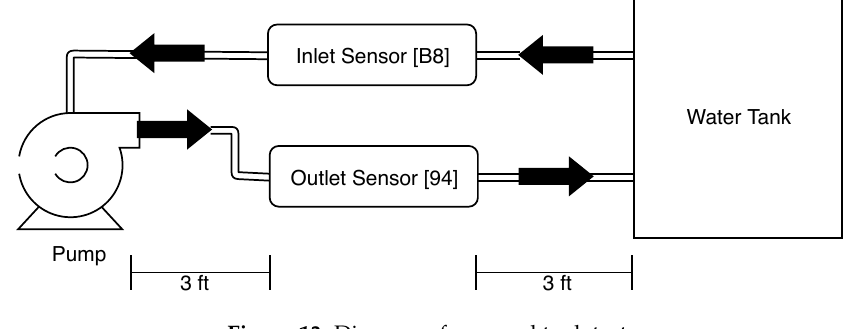
Figure 13. Diagram of pumped tank